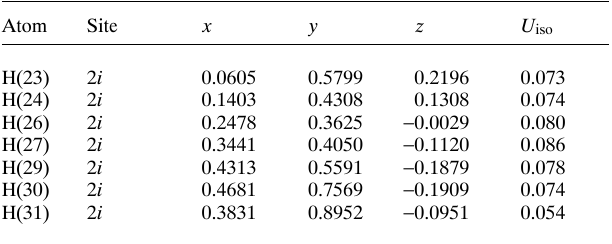
Table 2. C ontinued .